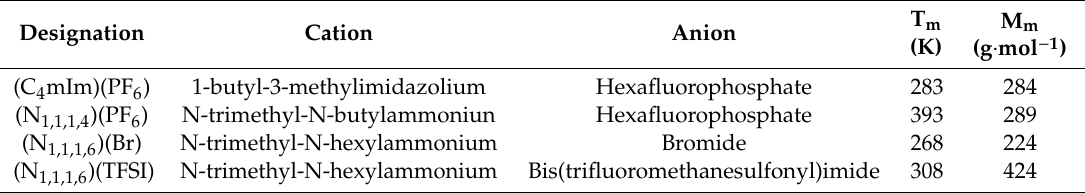
Table 1. Designation of imidazolium and ammonium ILs used in this